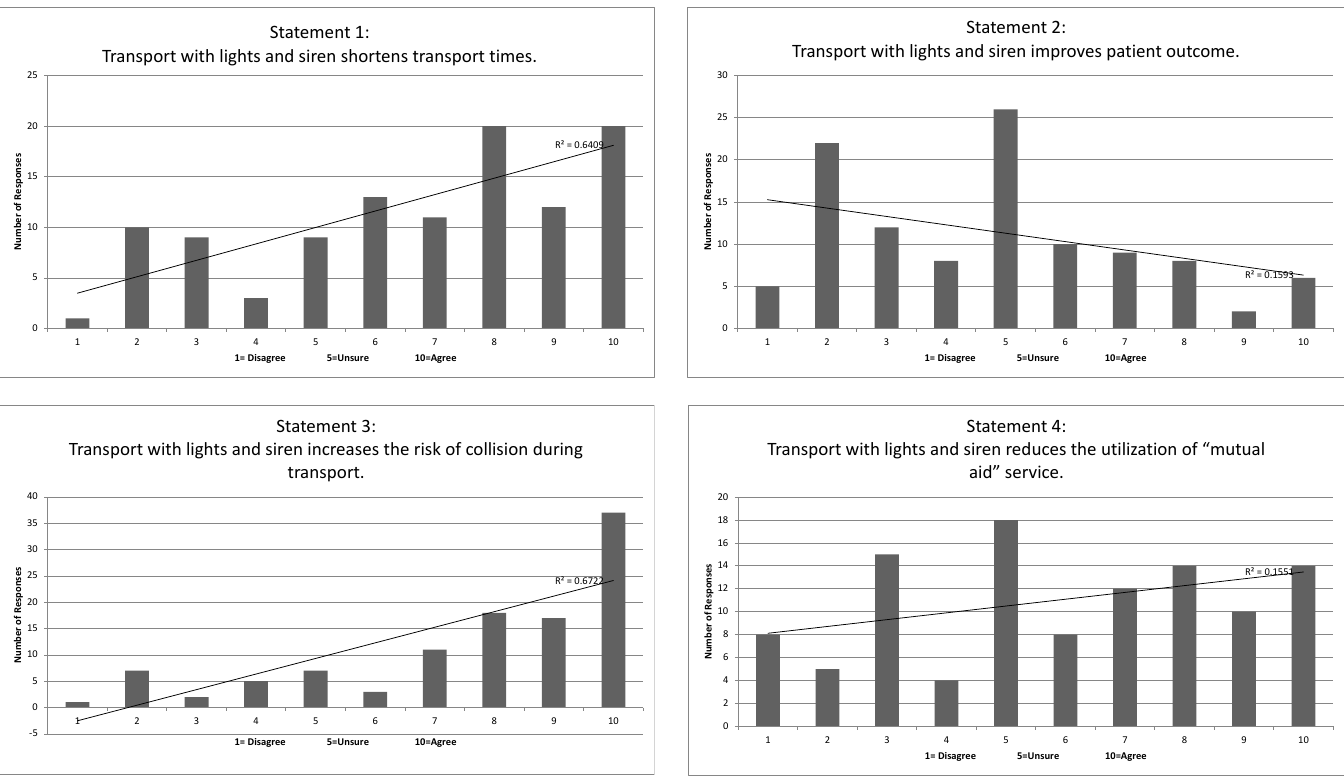
Figure 3. Distribution of total responses from emergency medical services (EMS) providers.